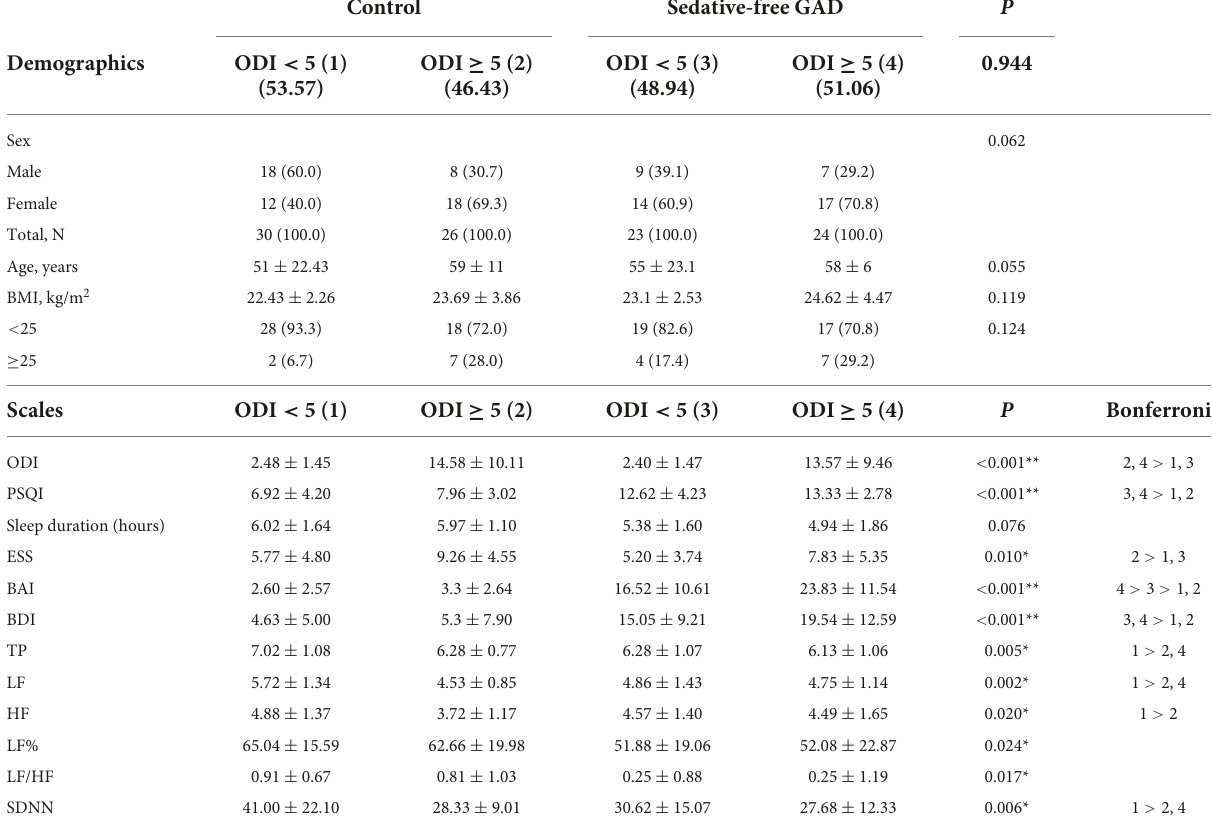
TABLE 2 Comparison of demographic data and clinical characteristics of the study participants by ODI subgroups. Control Sedative-free